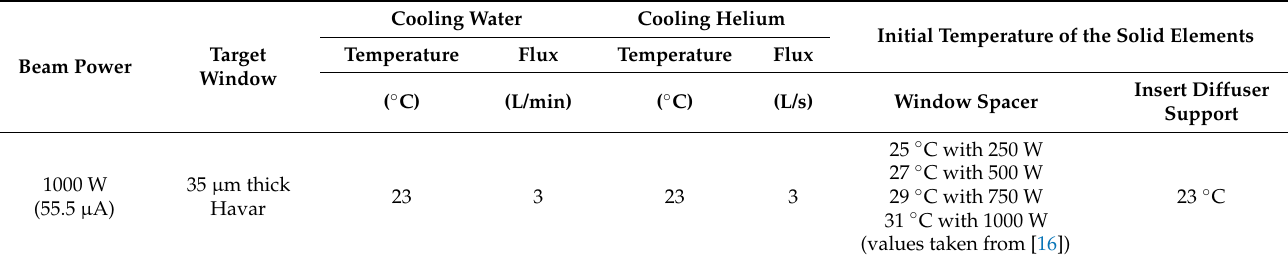
Table 2. Standards initial conditions of the